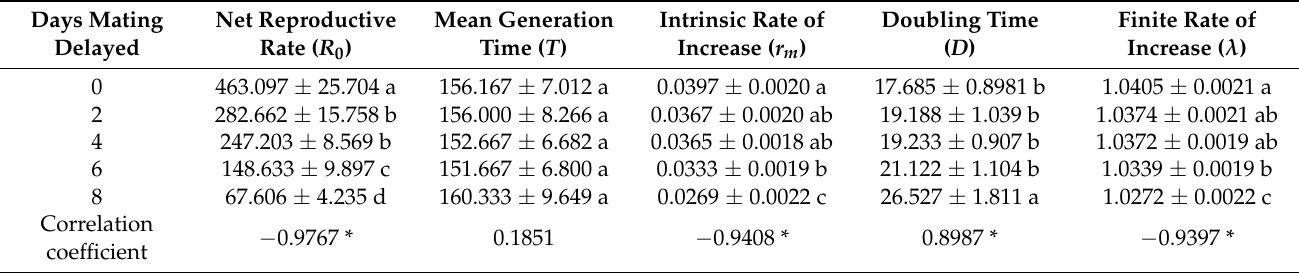
Table 4. Effect of H. vigintioctopunctata male-delayed mating on the life table